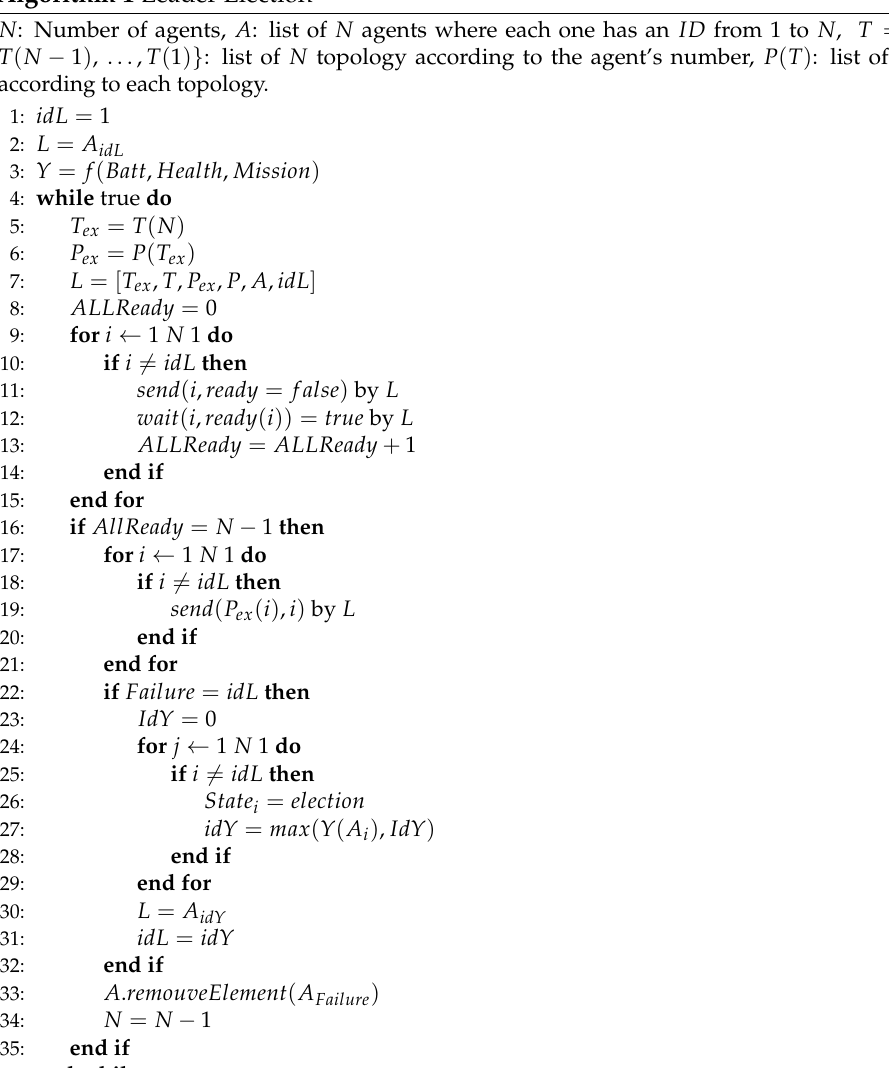
Algorithm 1 Leader